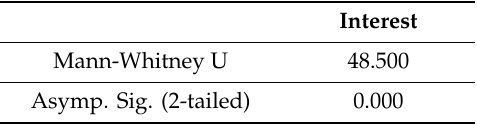
Table 13. Significance level Mann–Whitney’s U test.